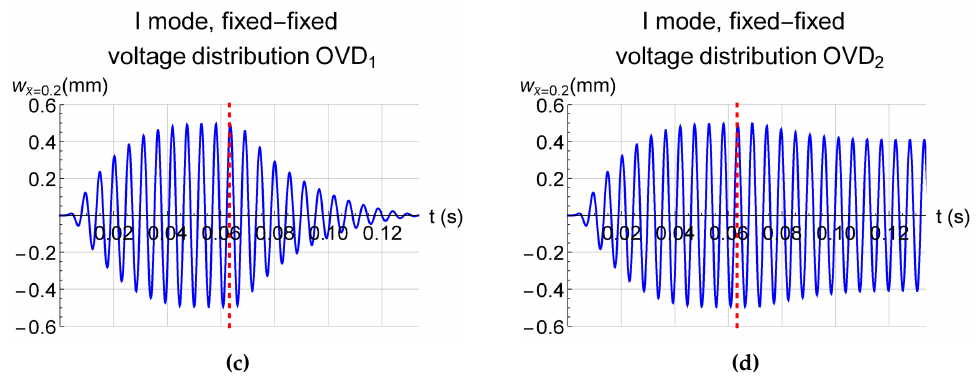
Figure 9. Example of the damping efficacy achieved activating the voltage distributions listed in Table 4. w ¯ x = 0.2 vs. time plots in the case of: ( a ) activation of the voltage distribution A, ( b ) activation of the voltage distribution B, ( c ) activation of the voltage distribution OVD 2 , and ( d ) activation of the voltage distribution OVD 1 . The first eigenmode of the fixed-fixed beam is excited by the external load F ( t ) , evenly distributed on the beam length, with F ( t ) = F 0 cos ( ω 1 t ) , F 0 = 15 N and ω 1 being the angular frequency of the first mode (1174.4 rad/s). The vertical displacement of a point located at ¯ x = 0.2 is used as the reference point. The dashed red line shows the instant of voltage distribution activation.